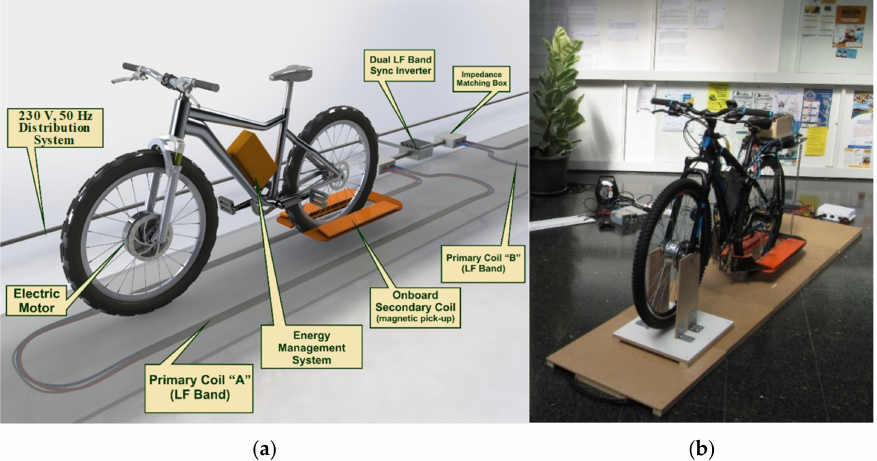
Figure 1. ( a ) E-bike adapted with an onboard energy harvest system positioned over a primary coil of